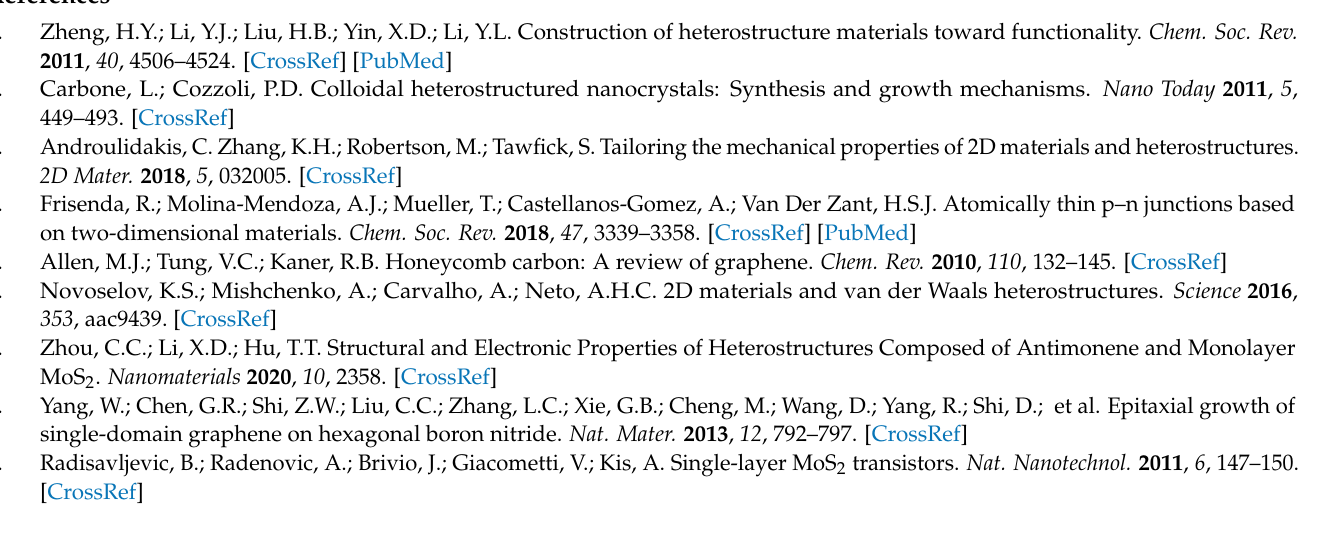
arm. Figure S2: Atomic reconstructed KBr lattice on Ir(111) measured by nc-AFM and filtered by FFT, respectively. Figure S3: nc-AFM images of a KBr island on Gr/Ir(111) before and after tip manipulation with downward and upward scanning directions,